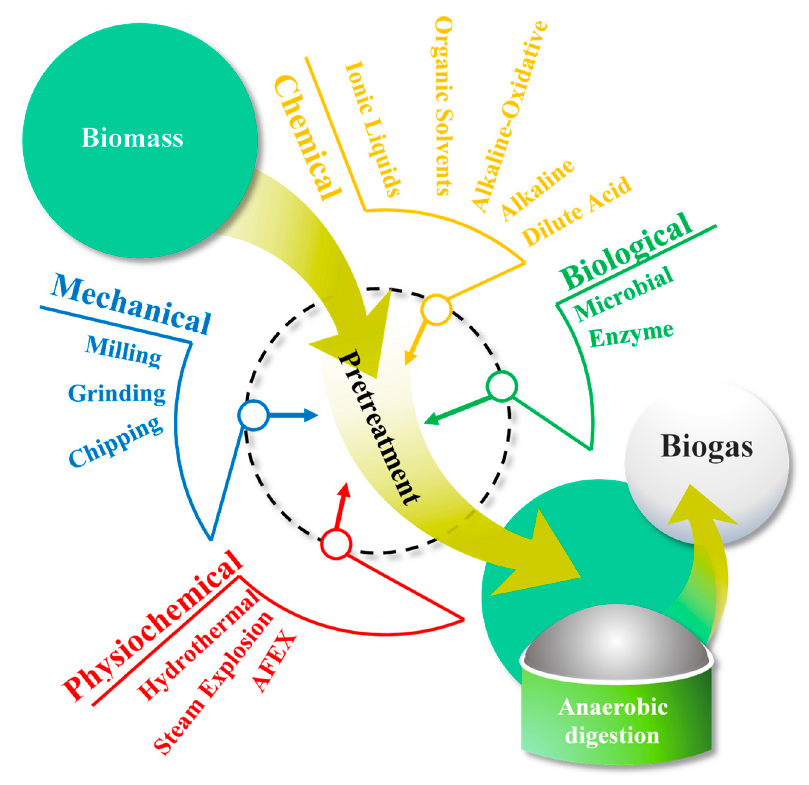
Figure 4. Pretreatment methods to increase the bioavailability of lignocellulosic biomass.